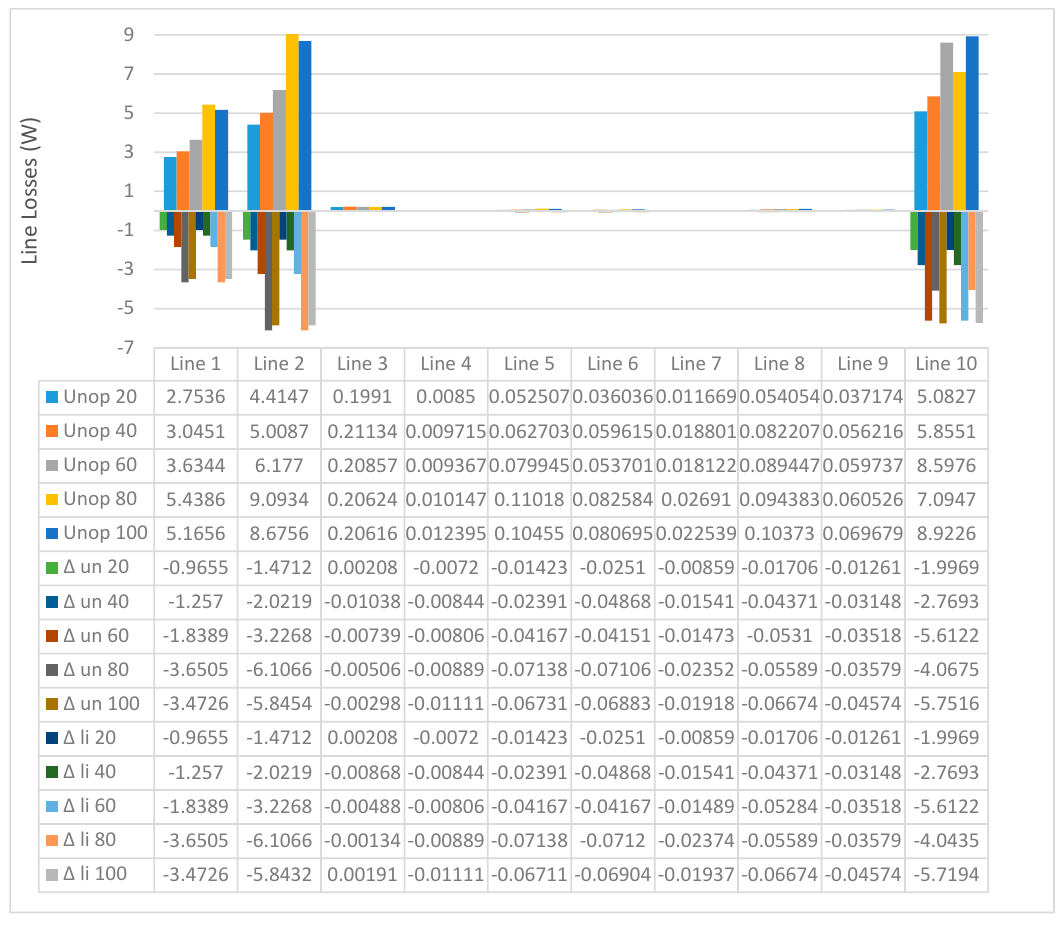
Figure 15. Worst case line losses observed (W): Unop (20–100): unoptimized with 20–100 EVs in the system; ∆ un (20–100) showing the change in line losses across individual cables when optimized with no limit on the configuration configuration for between 20–100 EVs and ∆ li (20–100) showing the results optimized for minimizing line losses across all lines with no limit on configuration for between 20–100 EVs.